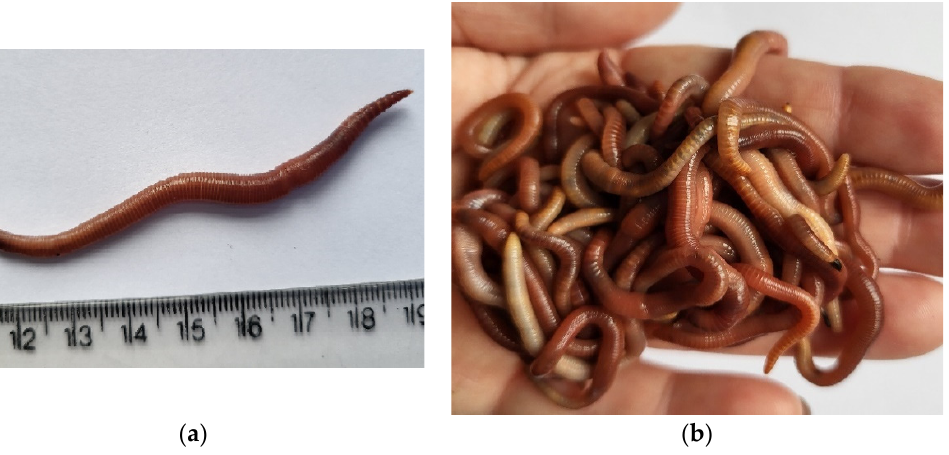
Figure 1. ( a ) A single adult Dendrobaena veneta ; and ( b ) as group taken from a bed for processing organic